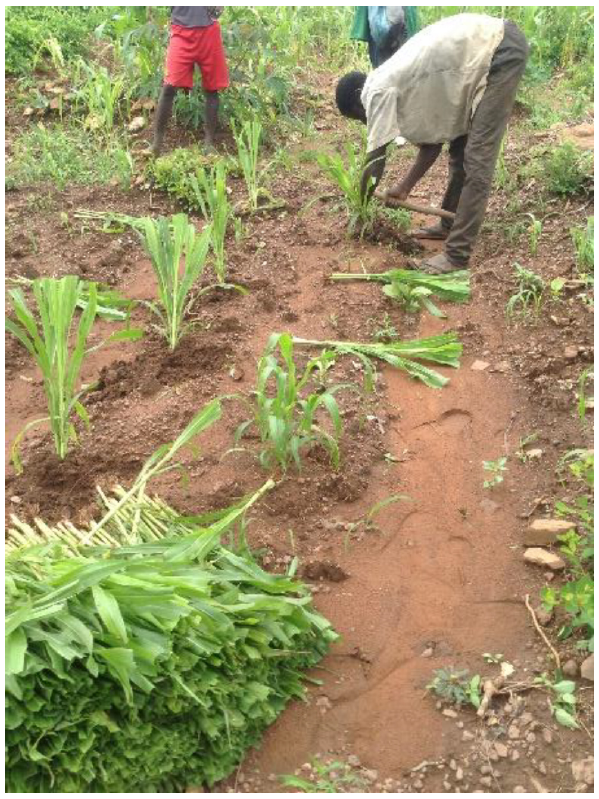
Figure 5. Photo 2 : Repiquage du sorgho dans le bassin Béninois de la Pendjari. Prise de vue : P. Ouassa, Septembre 2018.